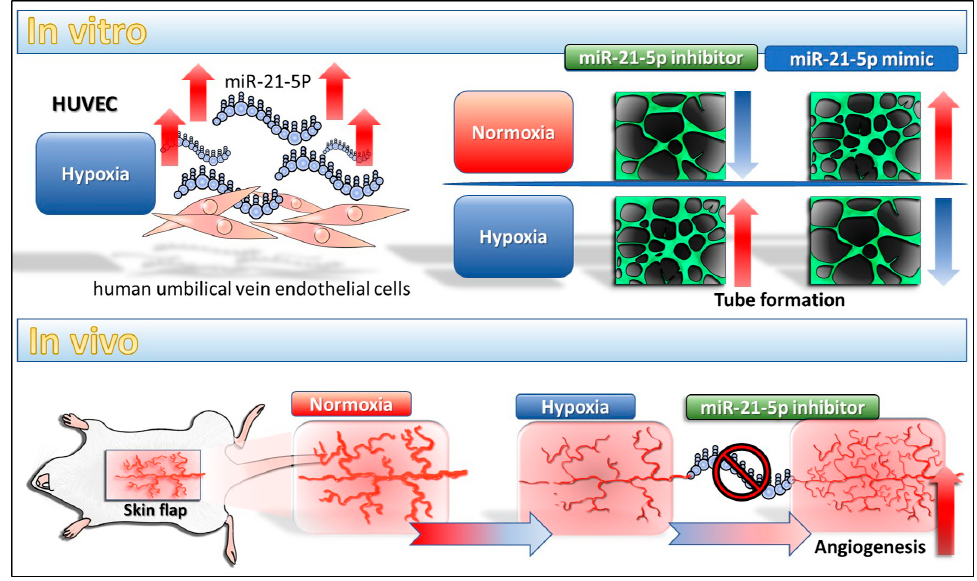
Figure 6. The proposed model of miR-21-5p in vitro and in vivo.